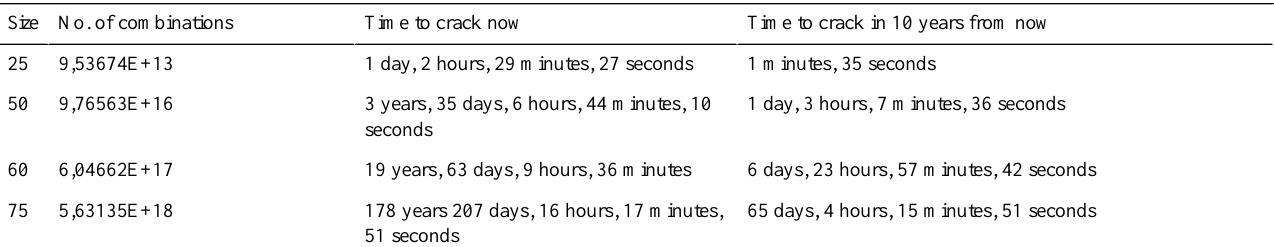
Table 2. Number of combinations of passwords of length up to 9 and maximum time to crack them now and in 10 years.